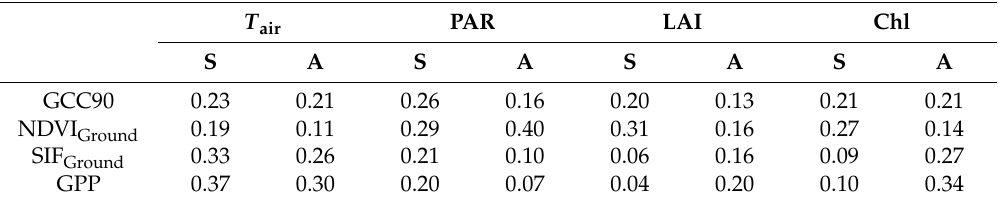
Table 3. The Mean Absolution Error (MAE) of the surface air temperature ( T air ), photosynthetically active radiation (PAR), leaf area index (LAI) and leaf chlorophyll content (Chl) versus the 90th percentile of the green chromatic coordinates (GCC90), ground-based NDVI (NDVI Ground ), ground-based